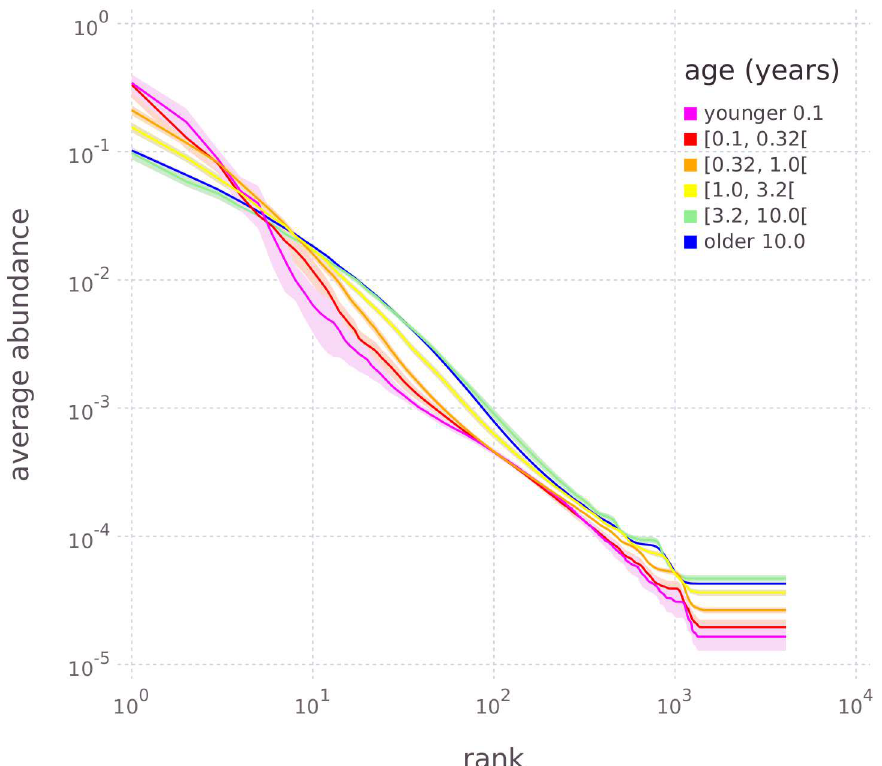
Fig 8. Averaged NRADs of gut microbiome data in six age groups. The numberof NRADs per group from youngestto oldest were 9, 18, 55, 64, 34, and 309, respectively.Solid lines are mean NRADs, shadedareas are 90% confidenceintervals for the